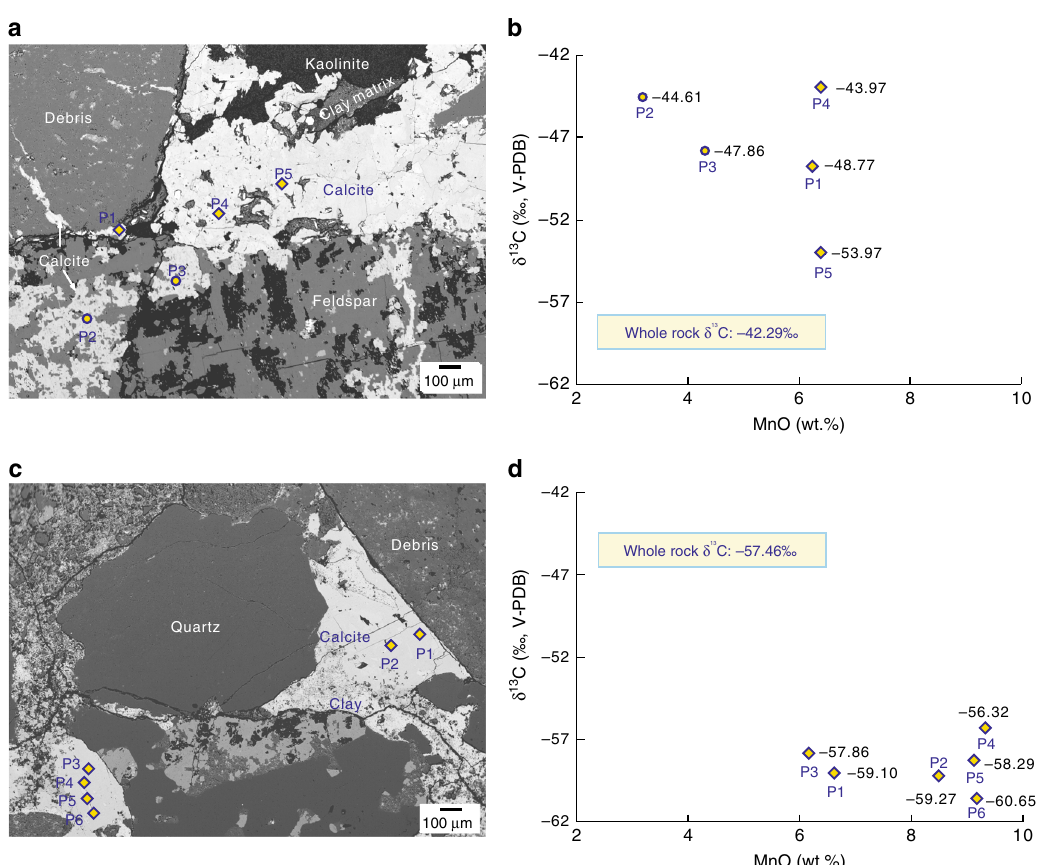
Fig. 2 Back scattered electron microscopic images of sandy conglomerates from the Baikouquan Formation, with crossplots of in situ δ 13 C and Mn contents of authigenic calcite. a , c Sandy conglomerate from the T 1 b 3 member (3824.2m in Well M18), with two generations of calcite cement. The early-stage cements have consistently lower MnO content than the late-stage cements. b , d Sandy conglomerate from the T 1 b 2 member (3866.9 m in Well M18), cemented by calcite with higher MnO content. Circles indicate measurements of early-stage calcite, diamonds represent measurements of late-stage cements. The overall values of late-stage calcite δ 13 C are lower than those of the early-stage calcite. The error bars, referring to the standard error of the mean (SEM) in this paper, is smaller than the symbol size in the